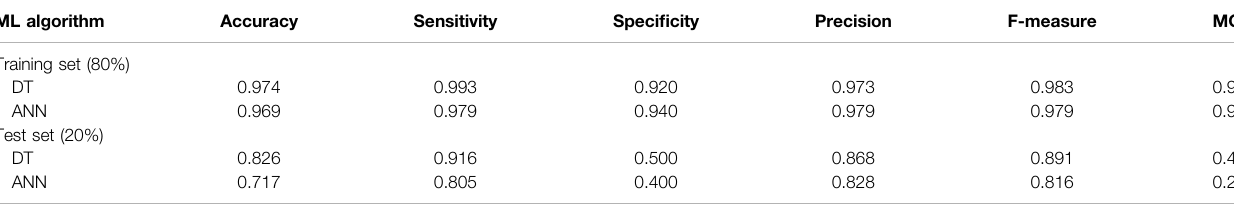
TABLE 1 | Statistical parameters of classi fi cation models, J-48 decision tree and MLP neural network, for training data calculated from WEKA. ML